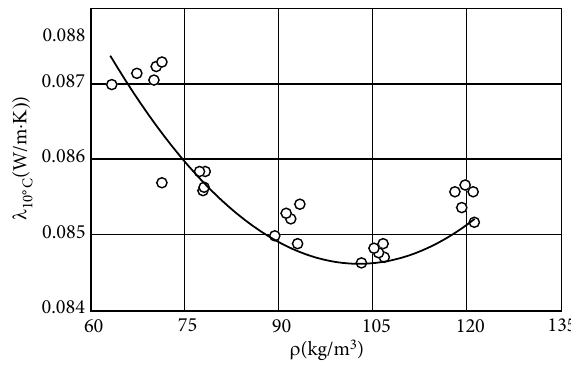
Fig. 3. The dependence of thermal conductivity on the density of vertically oriented straw